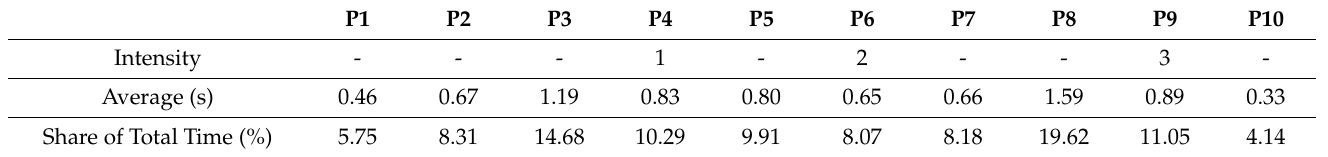
Table 3. Fixation times in the first product category with shadow highlights. Source: own elaboration.